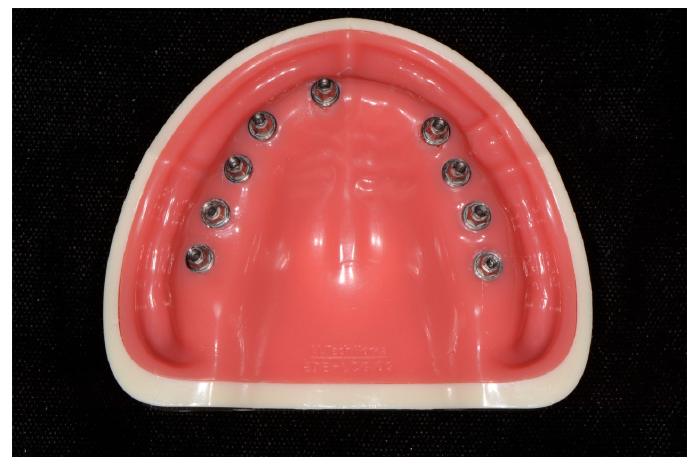
Figure 1. Placed implants with multiple abutments.